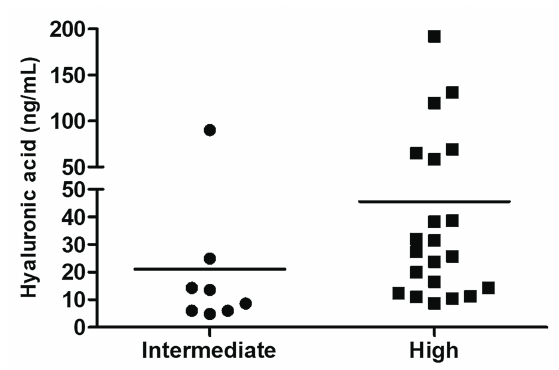
Figure 2 - Hyaluronic acid in prostate cancer patients according to D’Amico’s risk classification (Intermediate and High). There was a significant difference in the amount of plasma hyaluronic acid comparing the group of intermediate and high D’Amico’s risk. p = 0.0214,